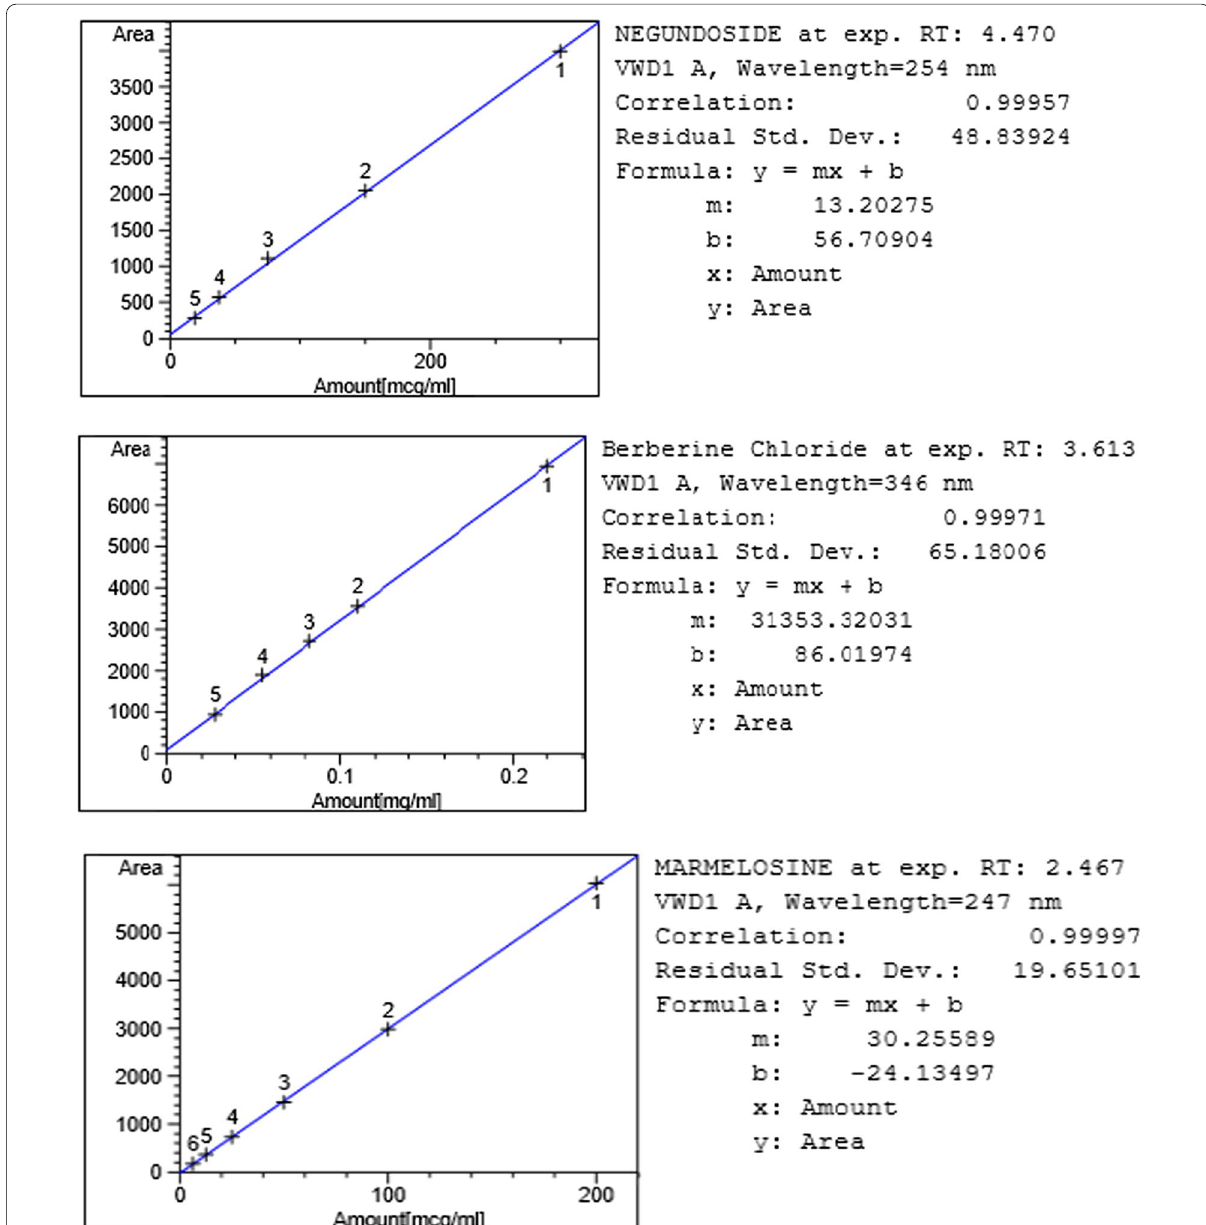
Fig. 2 Calibration curve and regression coefficient of Negundoside, Berberine chloride, and